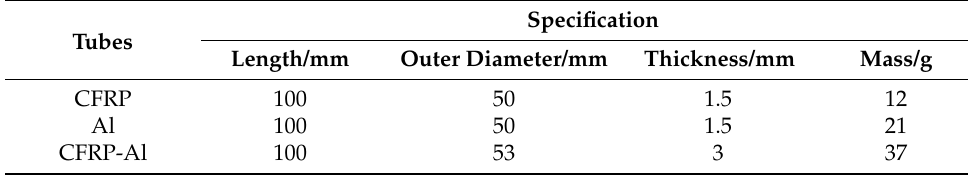
Figure 3. Three types of thin-walled circular tubes: ( a ) Al tubes; ( b ) CFRP tubes; ( c ) CFRP-Al tubes.